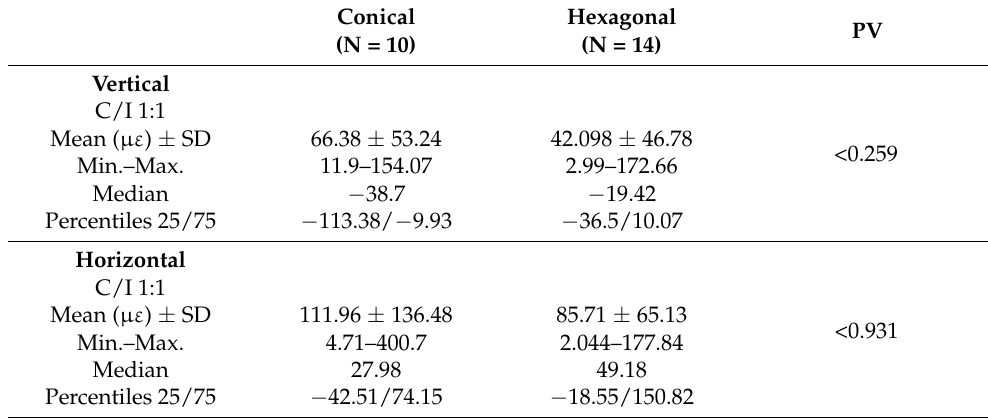
Table 3. Intragroup comparison of hexagonal connection and conical connection values of the BLI when C/I ratio is 1:1 and 2:1. µε are related in both connections and C/I ratio at the same implant